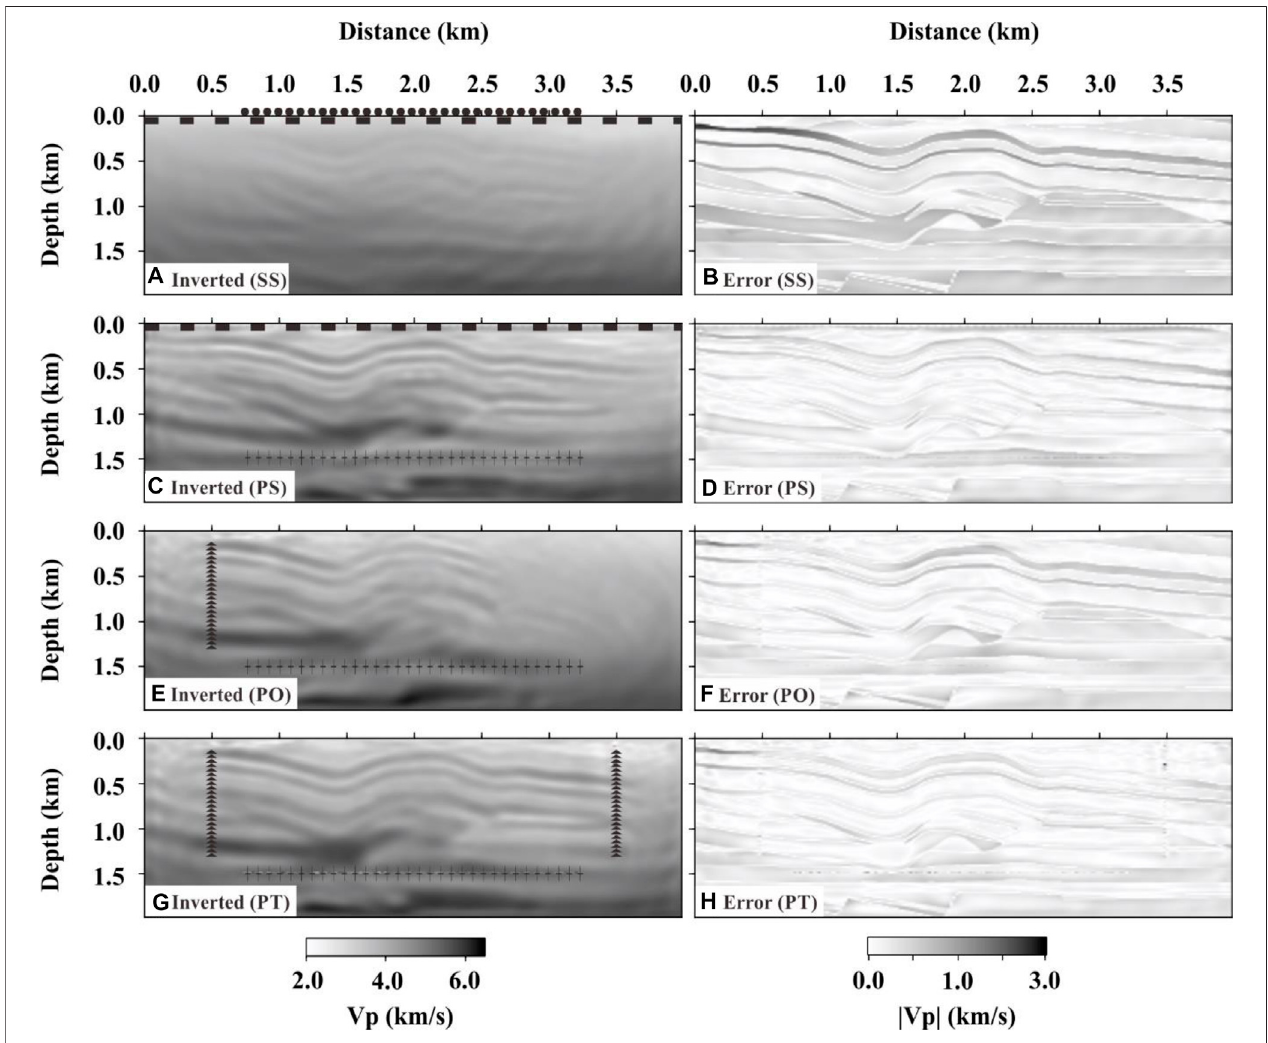
FIGURE 13 | Inversion results (left) and absolute velocity error (right) of SS, PS, PO, and PT data with fi eld noise (S/N = 2). (A) Result of SS. (B) Absolute error between the inverted velocity in (A) and the exact velocity (Figure 2) . Similarly, (C,D) are from PS, (E,F) from PO, and (G,H) from PT. The results of SS, PS, PO, and PT data are marked in the lower left corner of each block and presented in order from the top to the bottom.